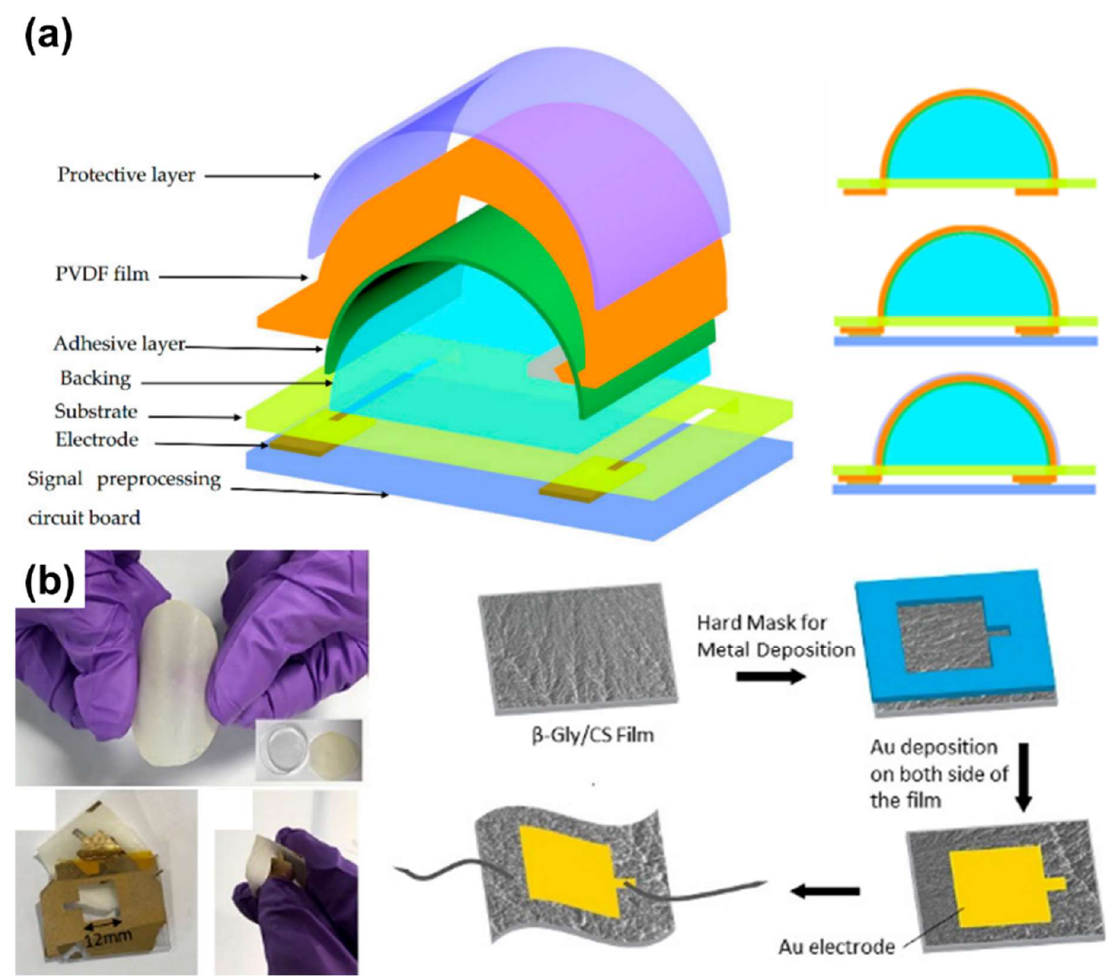
Figure 3. Schematic illustrations of fabrication processes and sensor structure. ( a ) Structure and fabrication of a wrist polyvinylidene fluoride sensor [71]. Copyright © 2021 by MDPI. Reproduction is permitted for noncommercial purposes. ( b ) Optical images of a glycine/chitosan (Gly/CS) film, deposited Au electrodes, and fabrication of a flexible piezoelectric Gly/CS-based pressure sensor [75] . Copyright © 2021 American Chemical Society.